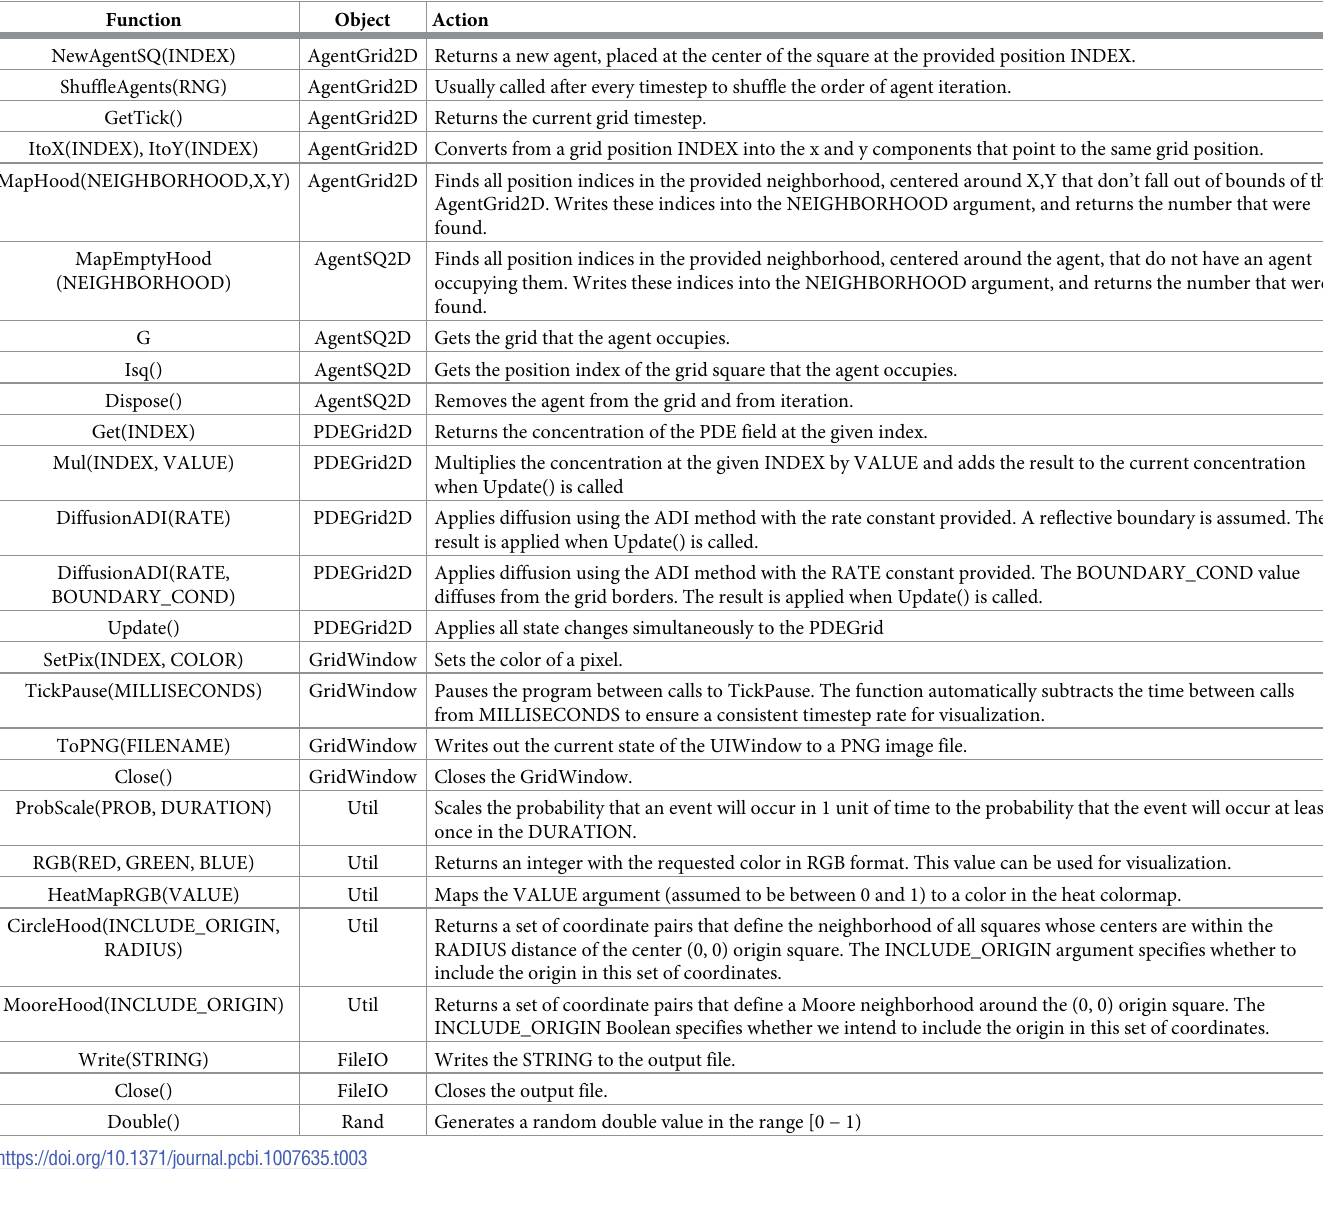
Table 3. HAL functions used in the example. Each function is a method of a particular object, meaning that when the function is called it may use properties that pertain to the object that it is called